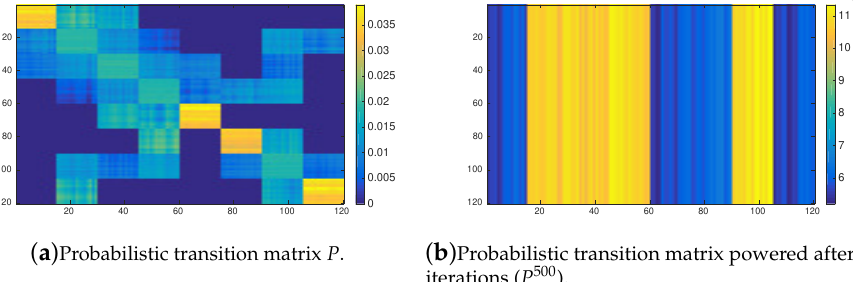
Figure 6. Probabilistic transition matrix induced by the YPRF with nTH = 2 for the 120 tasks arranged into 8 clusters.